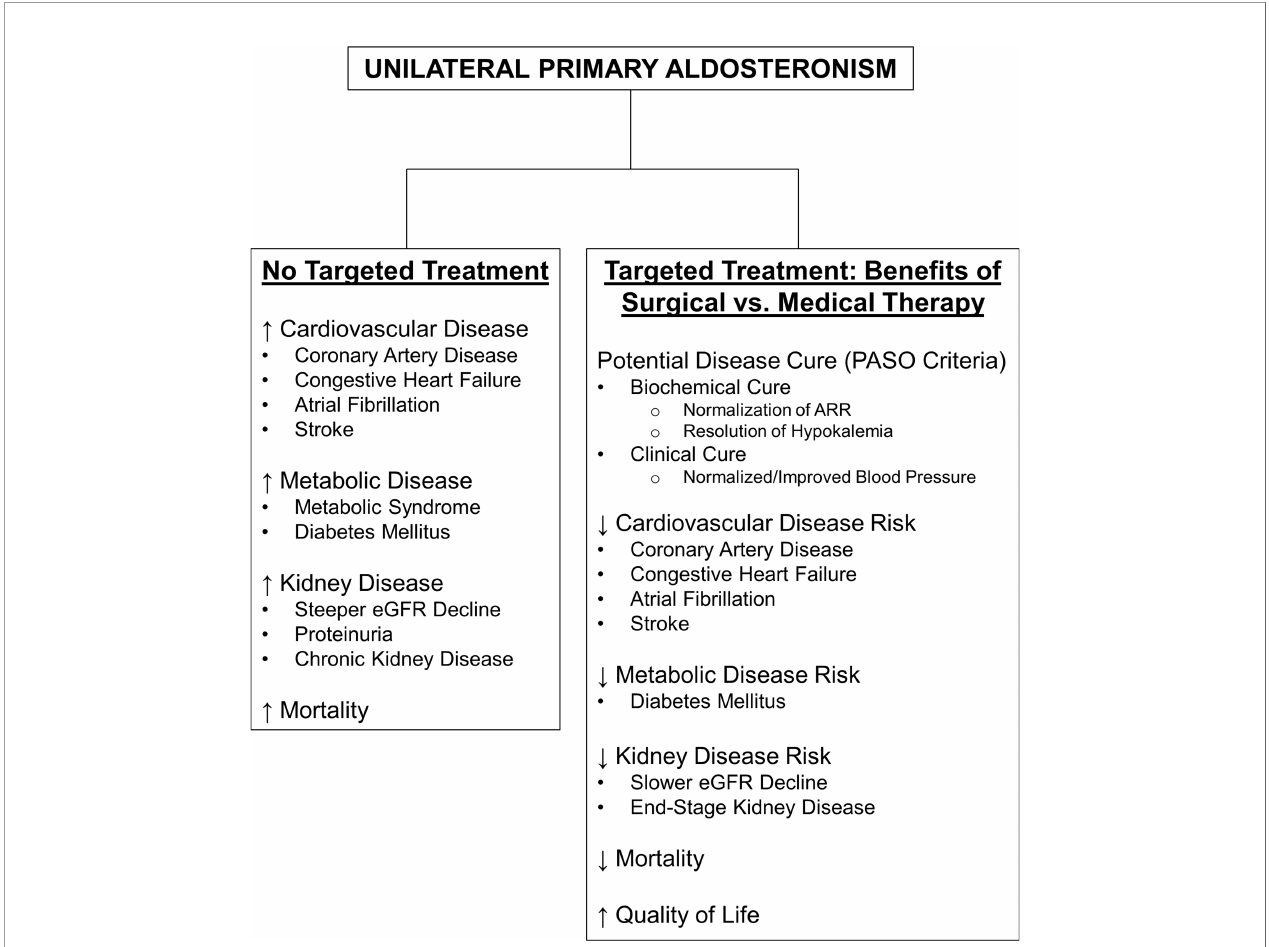
FIGURE 1 | Summary of the Health Impact of Untreated Primary Aldosteronism and the Bene fi ts of Surgical vs. Medical Therapy in the Treatment of Unilateral Primary Aldosteronism. ARR, aldosterone-to-renin ratio; eGFR, estimated glomerular fi ltration rate; PASO, Primary Aldosteronism Surgery Outcomes study